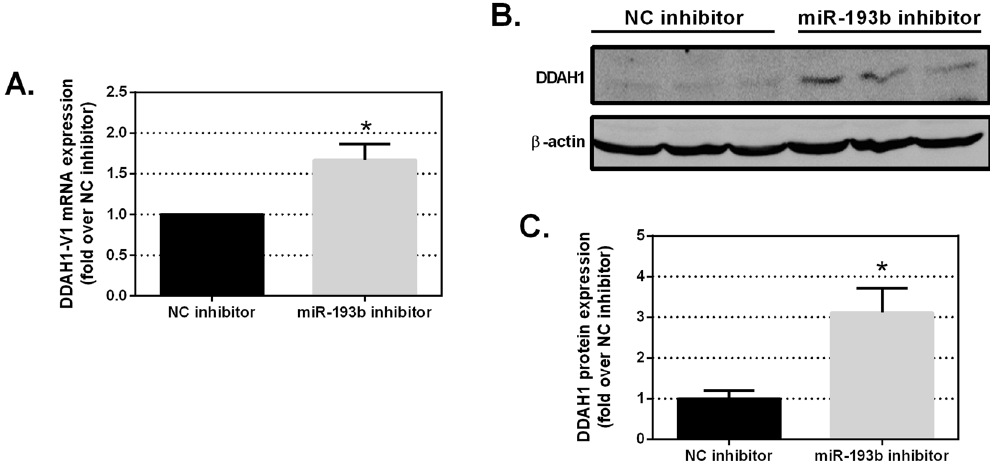
Figure 4. Inhibition of endogenous miR-193b increases DDAH1 mRNA and protein expression in MCF7 cells. ( A ) DDAH1 mRNA expression levels were assessed following transfection of 100 nM control inhibitor or targeting miR-193b inhibitor. Expression levels were assessed 48 hr post-transfection by quantitative RT-PCR and normalised to expression of 18S. Expression of DDAH1 mRNA following miR-193b inhibitor transfection is expressed relative to the NC inhibitor transfection, set to a value of 1. ( B ) DDAH1 protein expression was assessed by western blotting 72 hr post-transfection. ß-actin expression was used to normalise for total protein. ( C ) Quantification of DDAH1 protein expression was conducted from three independent experiments and normalised to ß-actin expression. Data are shown relative to DDAH1 expression in NC condition, which is set to a value of 1. All data are the average of at least two independent experiments performed in triplicate. Error bars represent SEM. ** p < 0.01 and *** p < 0.001.